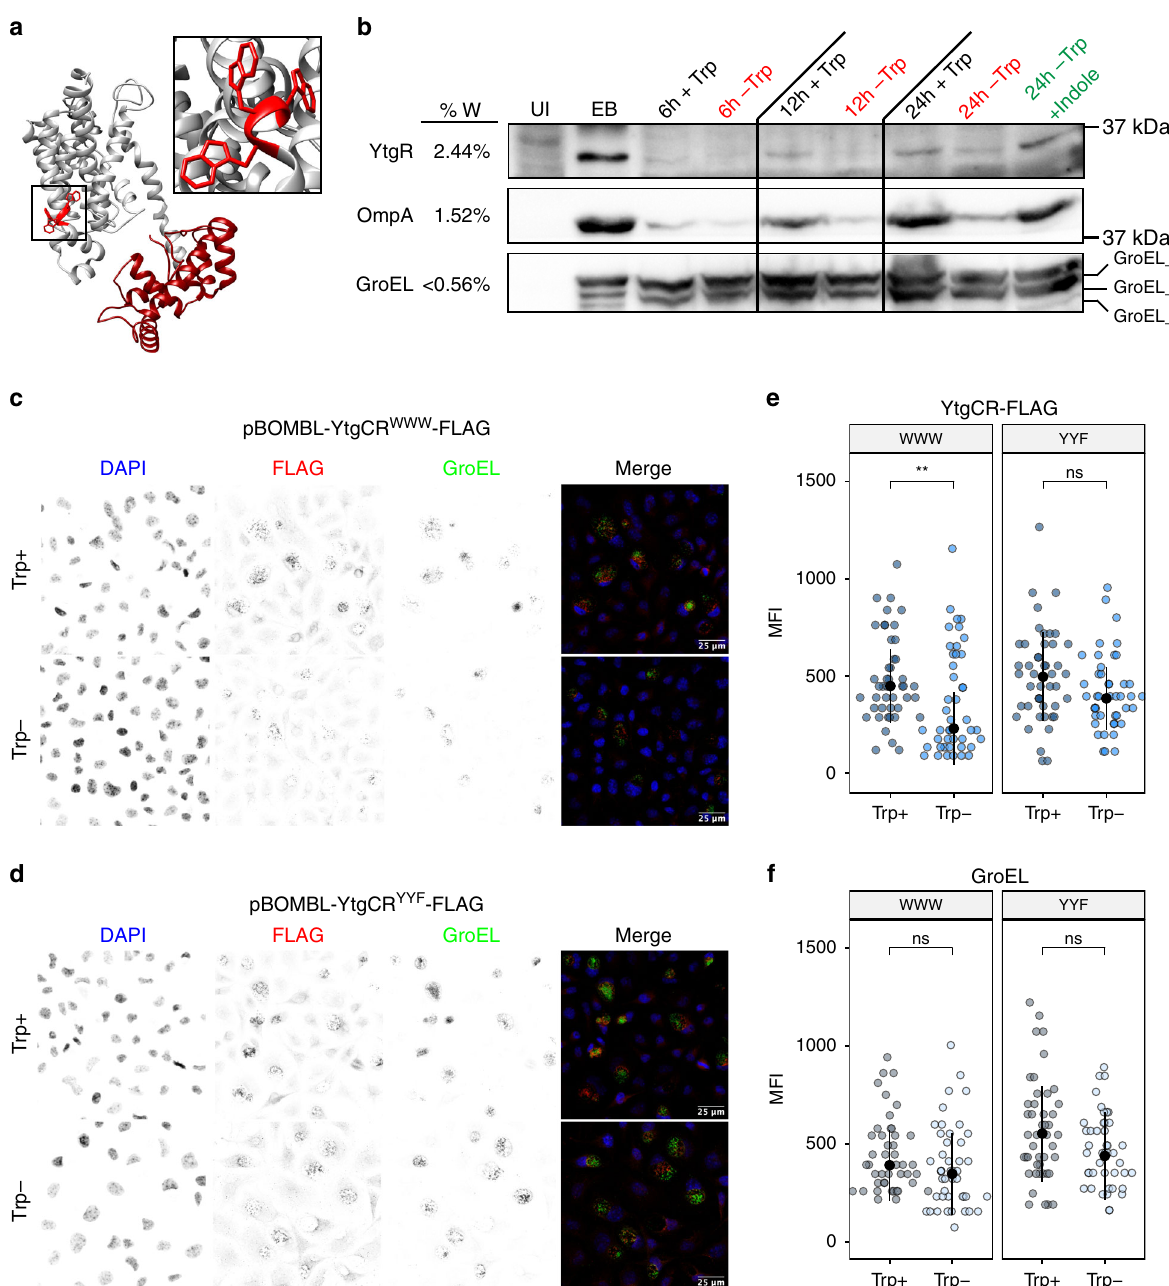
Fig. 2 Tryptophan-dependent expression of YtgR is mediated by the WWW motif in YtgC. a Ab initio structural model of YtgCR determined by the Phyre2 server. Inset shows the WWW motif. The gray region is the predicted YtgC ABC-type permease domain. The crimson region is the DtxR-like YtgR repressor domain. b Immunoblot of YtgR expression from C. trachomatis L2-infected HeLa 229 cells (MOI 5) under tryptophan-replete (Trp + ) or -deplete (Trp-) conditions. Expression of tryptophan-rich OmpA and tryptophan-poor GroEL_1 – GroEL_3 were monitored as controls. Tryptophan starvation was rescued by the addition of 10 µ M indole to the depleted media. UI uninfected. EB lysate from C. trachomatis elementary bodies (inoculum). Equivalent volumes of lysates collected in parallel were added to each well. Image is representative of two independent experiments ( N = 2). c Immuno fl uorescent confocal micrographs of FLAG expression from C. trachomatis L2 transformed with either pBOMBL-YtgCR WWW -FLAG or d pBOMBL-YtgCR YYF -FLAG under tryptophan-replete or -deplete conditions. McCoy B mouse fi broblasts were infected at an MOI of 5 in the presence of Penicillin G to select for transformants. Anhydrotetracycline was added at 20 nM to induce YtgCR-FLAG expression. GroEL was used as a counterstain to identify inclusions for quanti fi cation. Images representative of three independent experiments ( N = 3). e Quanti fi cation of mean fl uorescent intensity (MFI) from the FLAG channel in panels c and d . Black dot in dotplots indicates the population median and the error bars represent the median absolute deviation. f Quanti fi cation of MFI from the GroEL channel in panels c and d as performed above for panel e . Statistical signi fi cance in all panels was determined by pairwise two-sided Wilcoxon rank-sum test. * p < 0.05, ** p < 0.01, *** p < 0.001. Source data for this fi gure are provided in Source